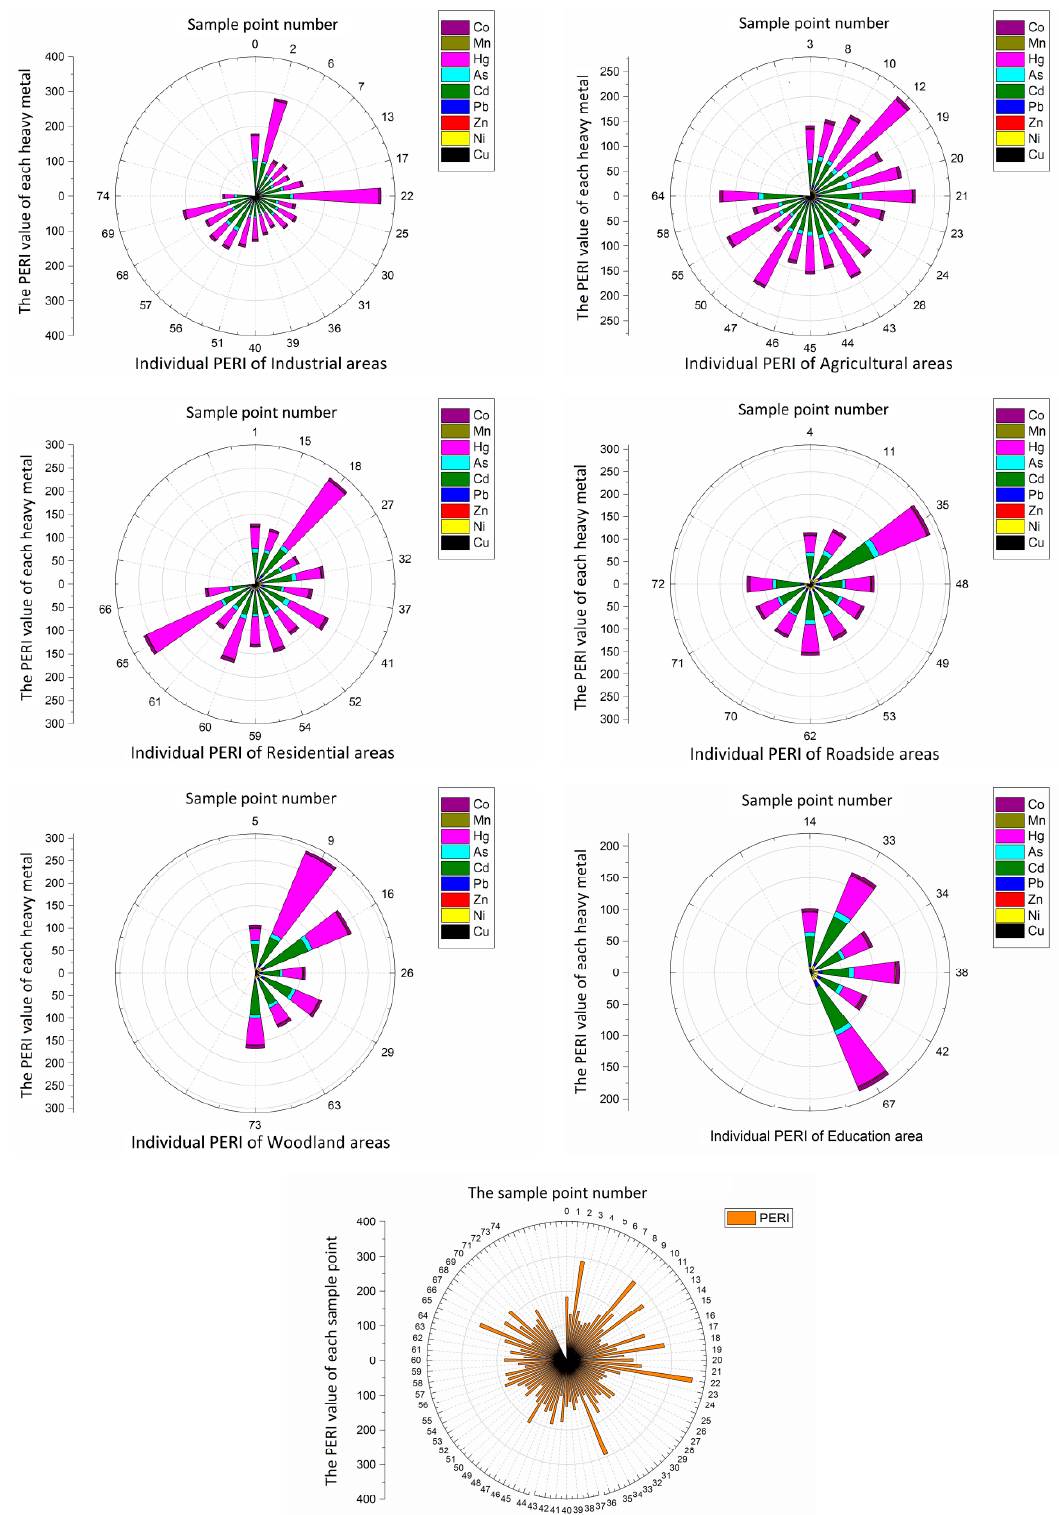
Figure 5. The wind roses of the potential ecological risk index (PERI) values for 9 heavy metals in the six functional areas and all six functional areas and all areas.